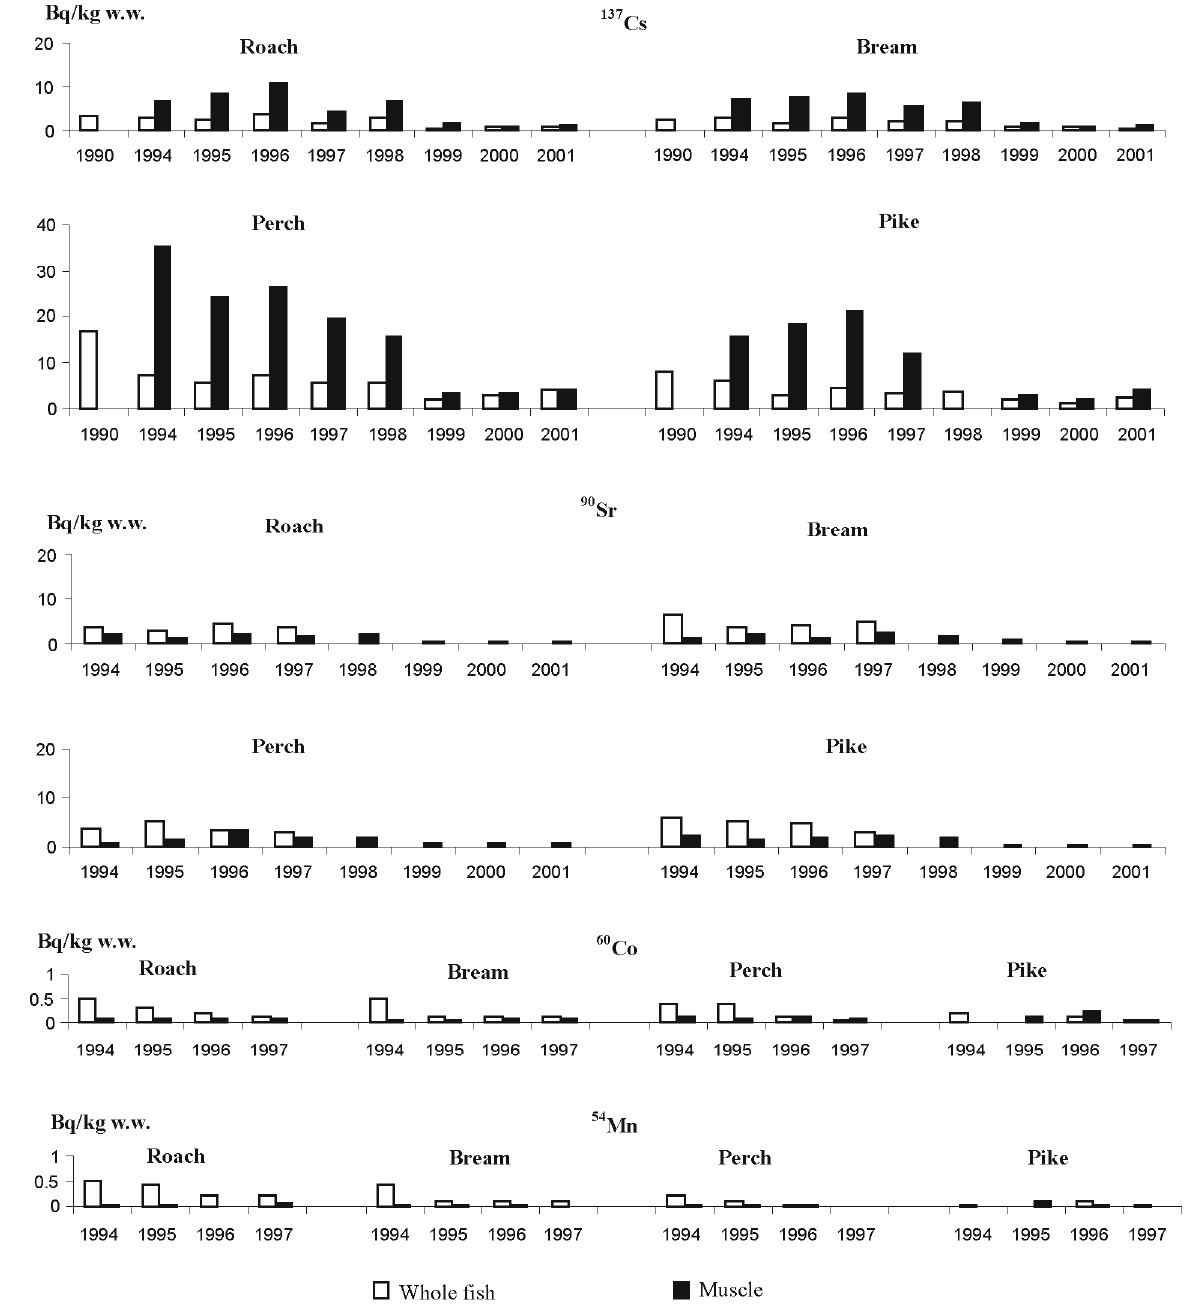
Fig. 6. Activity concentration of radionuclides in the whole fish and fish muscle from Drūkšiai